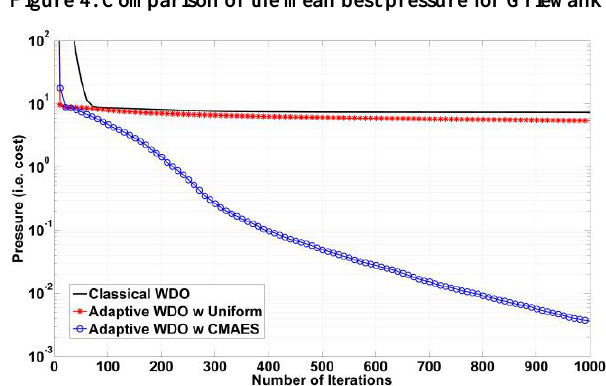
Figure 4. Comparison of the mean best pressure for Griewank.